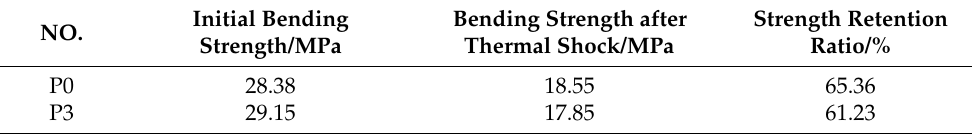
Table 6. Bending strength retention ratios for repair materials after thermal shock.